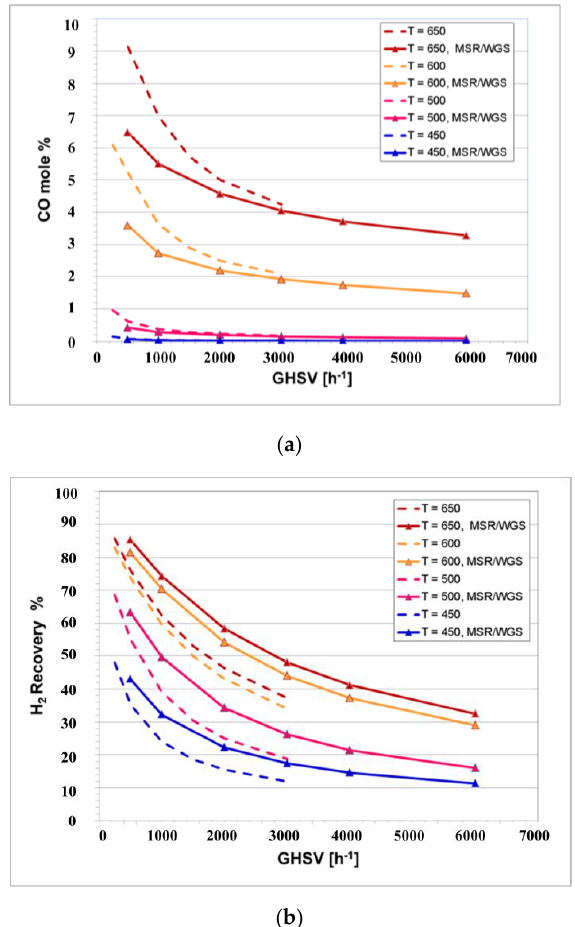
Figure 11. ( a ) CO yield and ( b ) H 2 recovery for single and dual CMRs at 5 bar and a carbon-to-steam ratio of five.